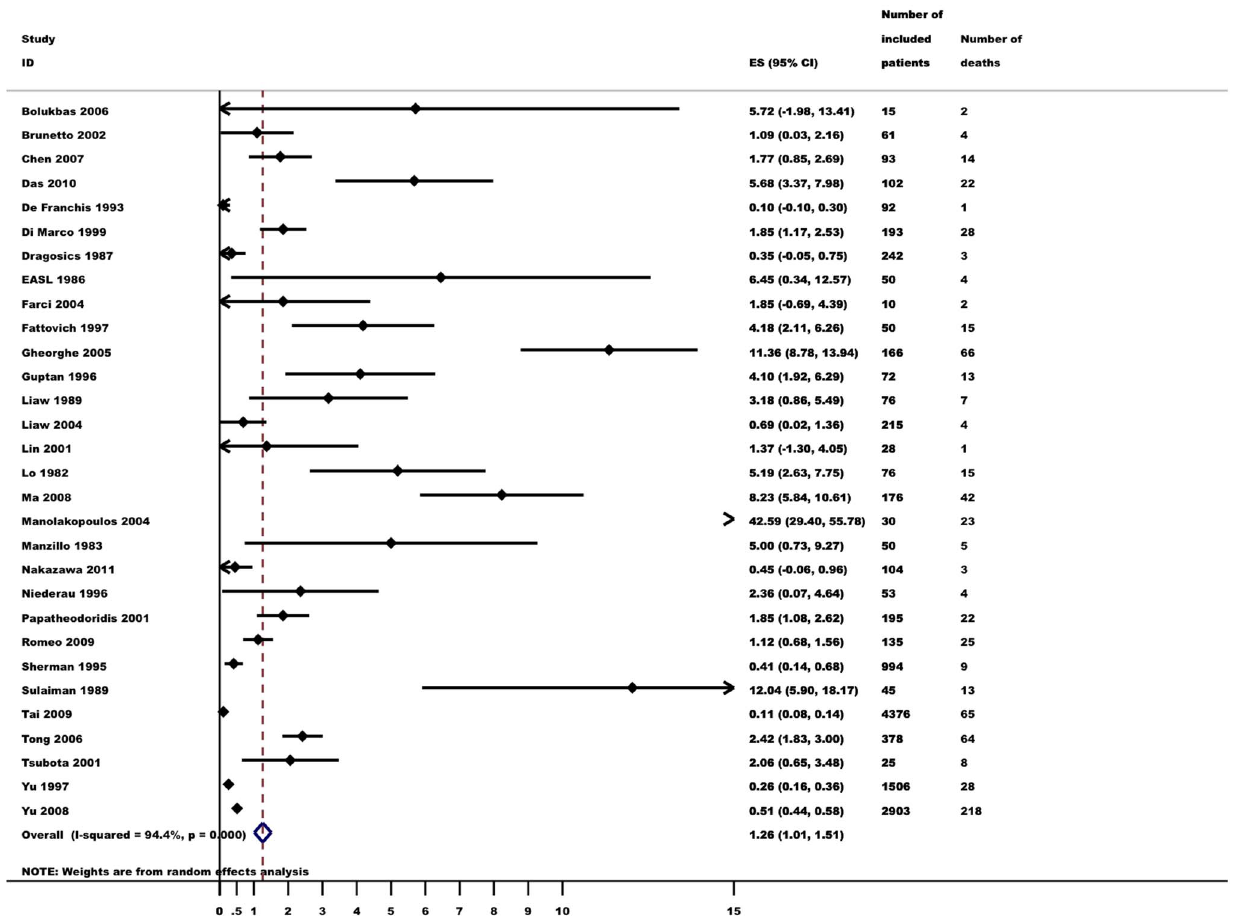
Figure 4. Annual mortality (events per 100 person-year) in untreated hepatitis B patients. Random effects meta-analysis.